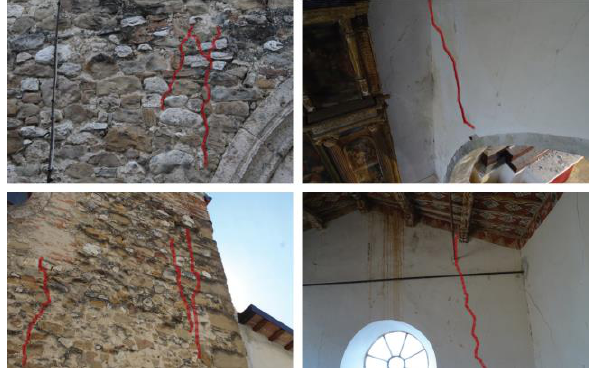
Figure 7 . Detailed photographic survey on-site